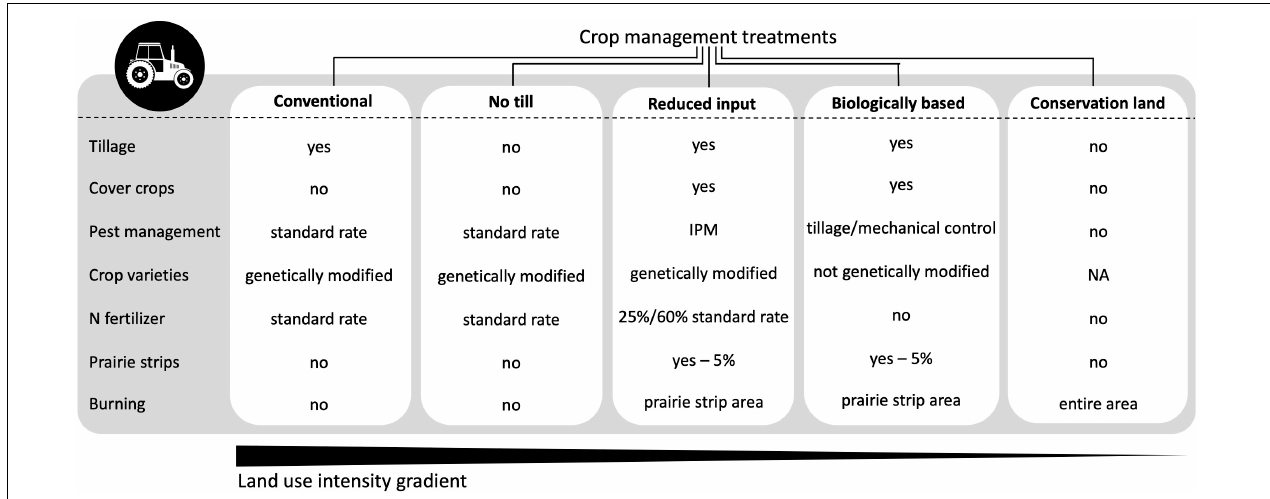
FIGURE 1 | Characteristics of experimental crop management treatments. Standard rate refers to Generally Accepted Agricultural and Management Practices. IPM (Integrated Pest Management) in the reduced input treatment refers to a combination of extra tillage (maize years), narrow row spacing (soy years), and reduced herbicide use, mostly related to the number of residual herbicides. Fungicides and pesticides are applied as problems arise and severity is assessed. Also regarding reduced input, N fertilizer is applied at 25% of the standard rate for maize, and at 60% of the standard rate for